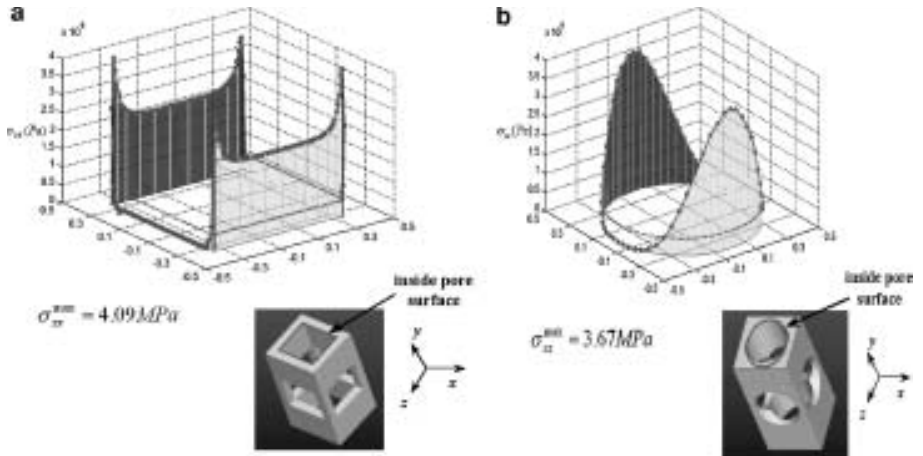
Figure 8 Comparison of local stress distribution along inside (a) square pore surface and (b) circular pore surface [29].